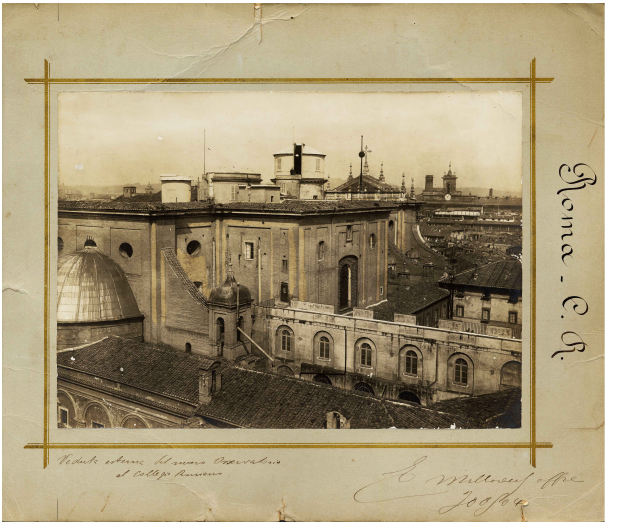
Photograph of the Collegio Romano